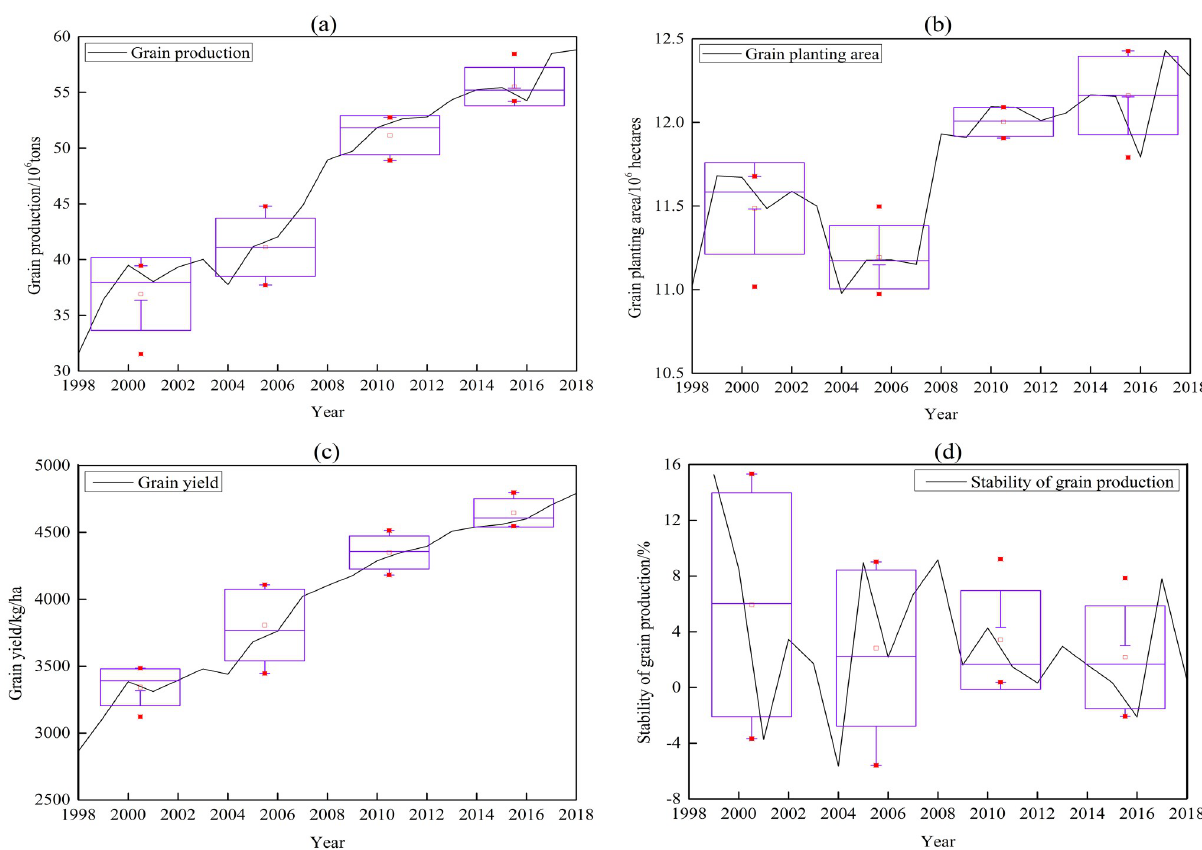
Fig 2. Grain crops production change in Bangladesh from 1998 to 2018. (a) Grain production, (b) Grain planting area, (c) Grain yield, and (d) Stability of grain production. The data of the boxplot are divided into 5 years, which are 1999–2003, 2004–2008, 2009–2013 and 2014–2018 respectively, similarly